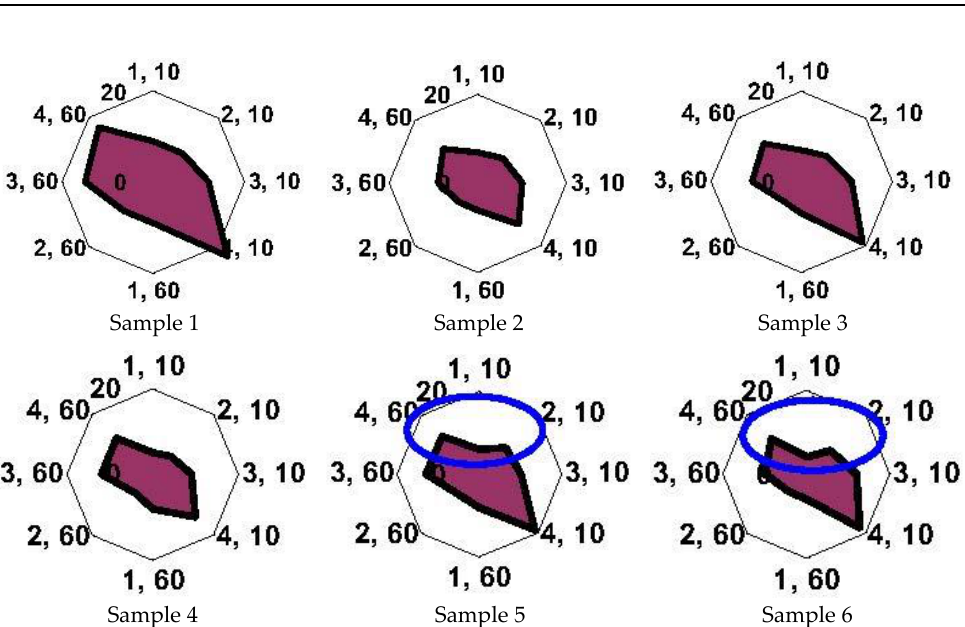
Figure 7. “Visual prints” of sensor responses in an array with polycomposite coatings in the EGP over EBC samples: numbers of sensors with polycomposite coatings in an array and scanning time (10, 60 s) are plotted along the radial axis. The part of “visual print” reflected the presence of disease in calf is selected by blue circles. Table 15. Parameters A ij ∑ for EBC samples, calculated considering the kinetic features of sorption on sensors with polycomposite coatings ( n = 4 – 5, S r (0.05) < 0.15).